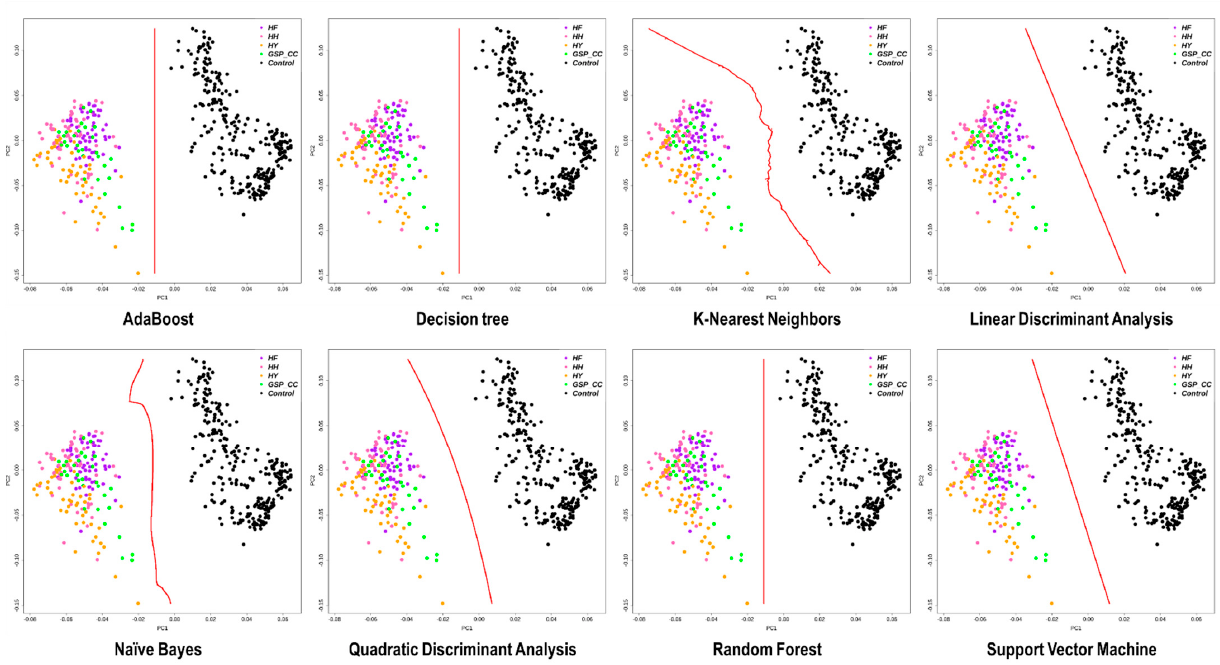
Figure 6. Classification results for the case and control groups, obtained by applying machine learning classification algorithms. All machine learning models could distinguish target (case) chicken populations from all other (control) chicken populations. HH, Hanhyup H; HF, Hanhyup F; HY, Hanhyup Y; GSP_CC, 3 way crossing offspring of HH, HF, and HY;Control, Other all chicken populations.